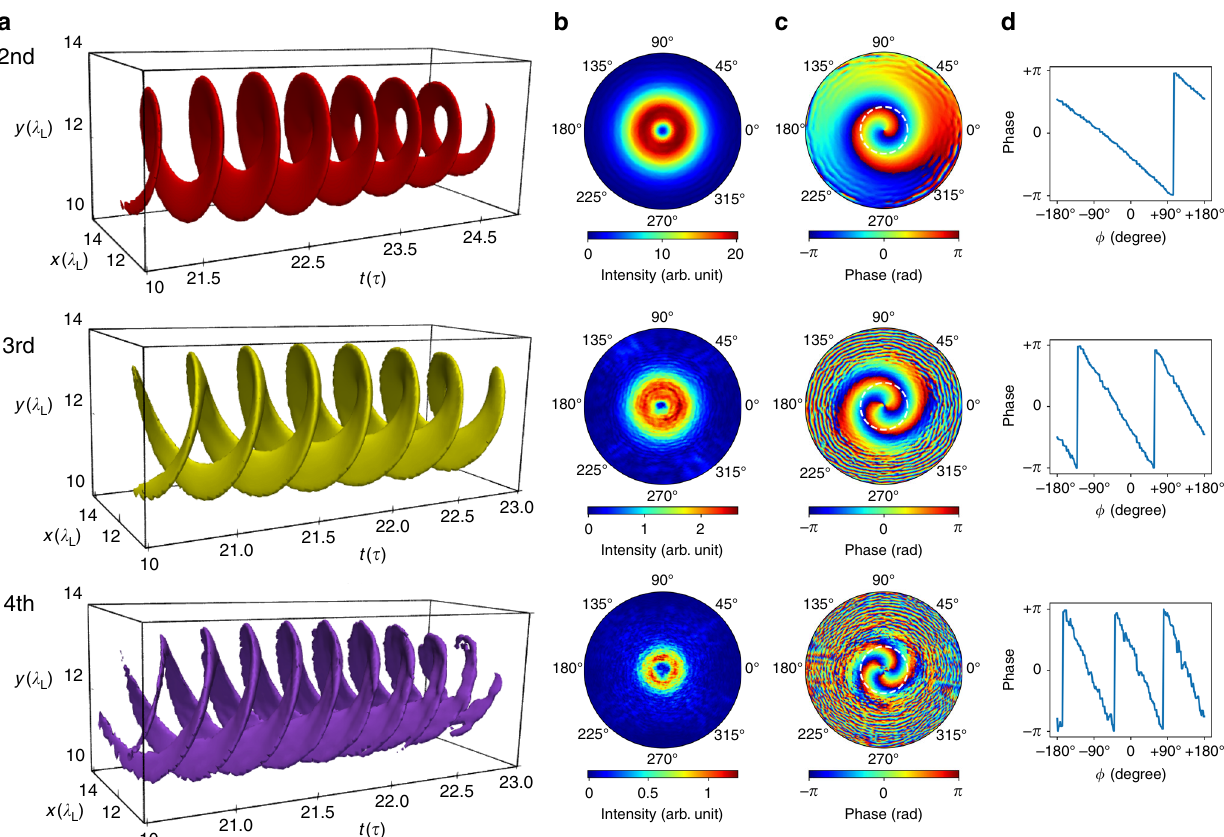
Fig. 2 Phase structures of the harmonics. a Isosurface distributions of the fi eld of each harmonic. The relative intensities for the three isosurfaces are 0.2 (red), 0.02 (yellow), 0.006 (purple), respectively. b Intensity distributions of each harmonic. c Phase distributions of each harmonic. d The dependence of phase on the azimuthal angle with constant radius. From the number of peaks of the serrated lines we can obtain the charge values of OAM. The fi rst, second, and third row correspond to the 2 nd , 3 rd , 4 th order harmonic, respectively. The pro fi les of the intensity and phase are obtained at a position z ¼ λ , where is 5 λ distance in front of the L L